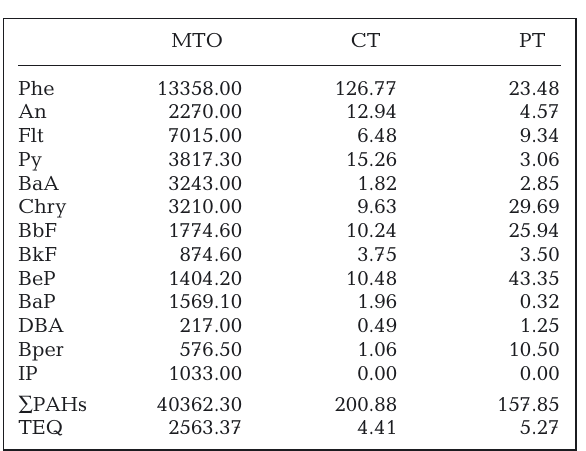
Table 2. Hydrocarbon composition of different tars com- monly used in the cleaning and maintenance of mussel rafts